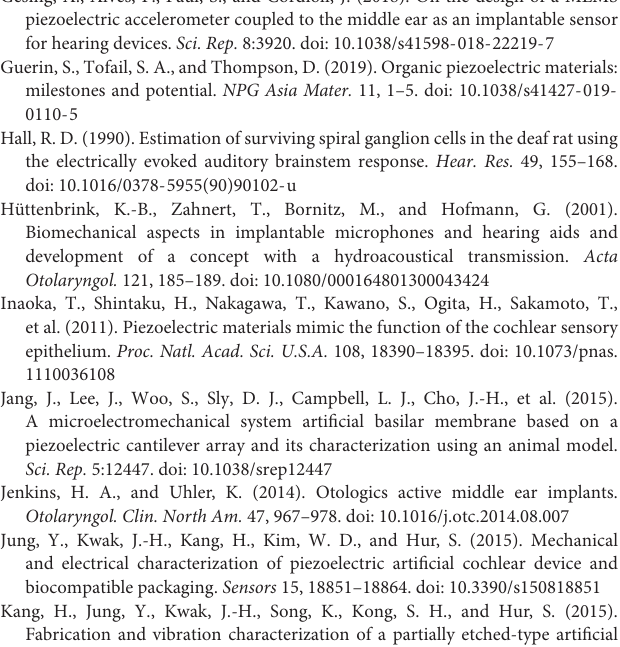
Supplementary Figure 1 | The photographs of surgical procedure for implantation in guinea pigs ( in vivo ). Under anesthesia, a retroauricular incision, a bullotomy, and cochleostomy was done. Then, the subjects were implanted with intracochlear stimulating electrodes into cochlea. Supplementary Figure 2 | Detailed design diagram for the length, diameter, and angle of tube-type connector (A) and rod-type connector (B) . Supplementary Figure 3 | The diagrams for several preliminary designs that changed the size and shape of the umbo connection site, the length and diameter of tube, and the angle of